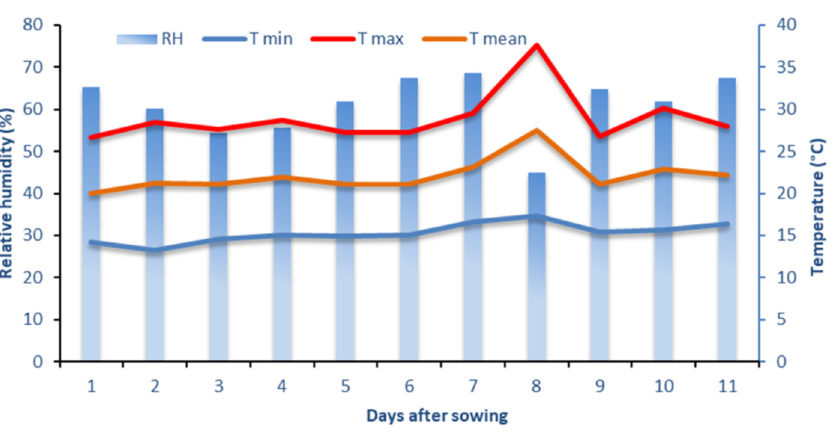
Figure 2. Greenhouse conditions during the microgreens crop cycle, 23 April 2020 to 3 May 2020: average temperature (T mean), maximum temperature (T max), minimum temperature (T min), and average relative humidity (RH).